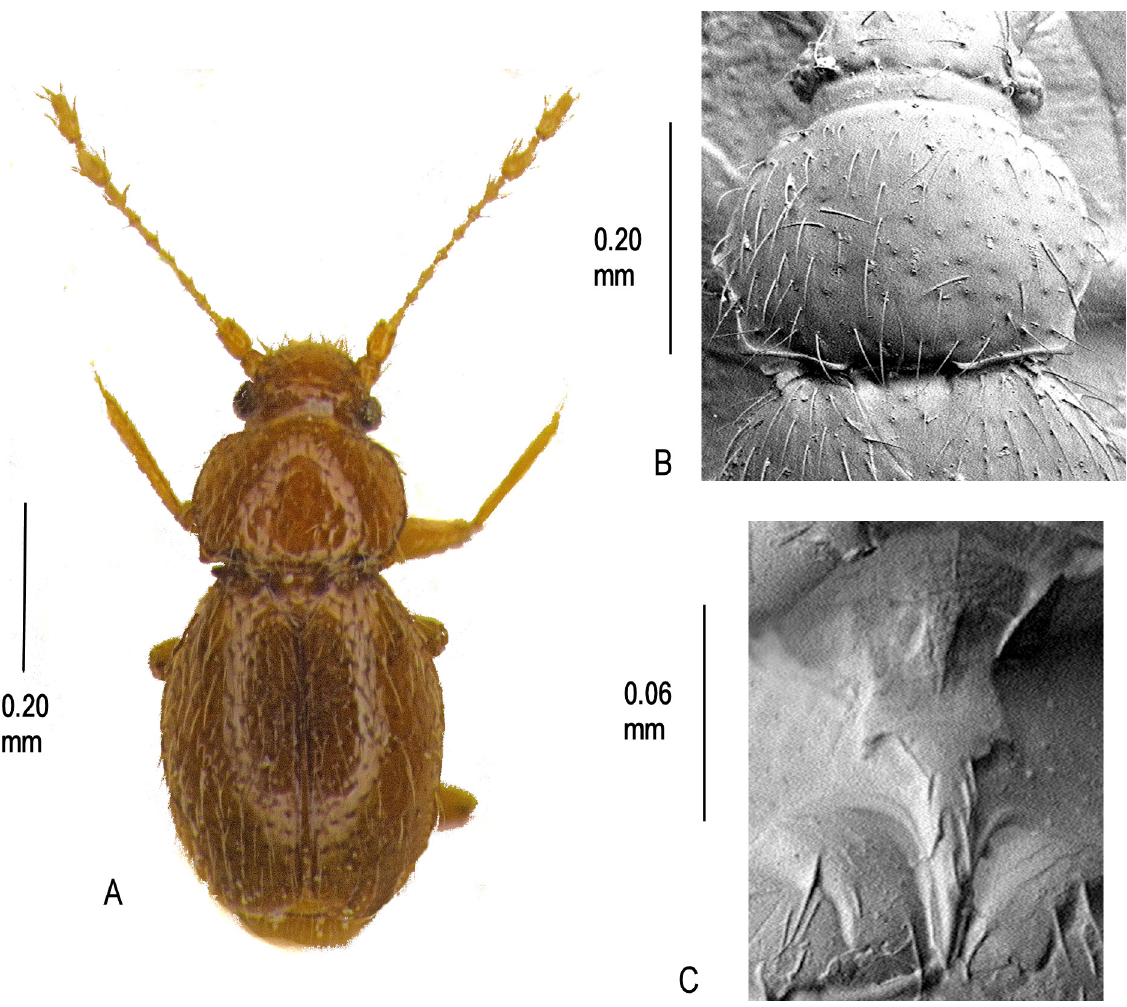
Fig. 82 . Cissidium seditiosum sp. nov. A . Habitus. B . Pronotum, × 470. C . Mesoventrite showing median process of collar, mid-keel and keel, ×